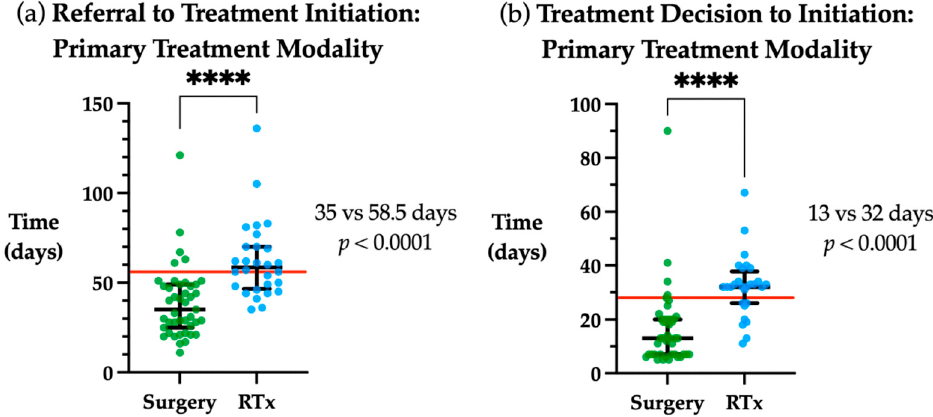
Figure 3. Time to treatment initiation by primary treatment modality. ( a ) Days from referral to treatment initiation for primary surgical or radiotherapy (RTx) treatment modality. ( b ) Days from treatment decision to initiation for primary surgical or radiotherapy treatment modality Red line indicates guideline timeframe, 56 days from referral to treatment initiation and 28 days from treatment decision to initiation. Median and interquartile range plotted in black. **** p < 0.0001.